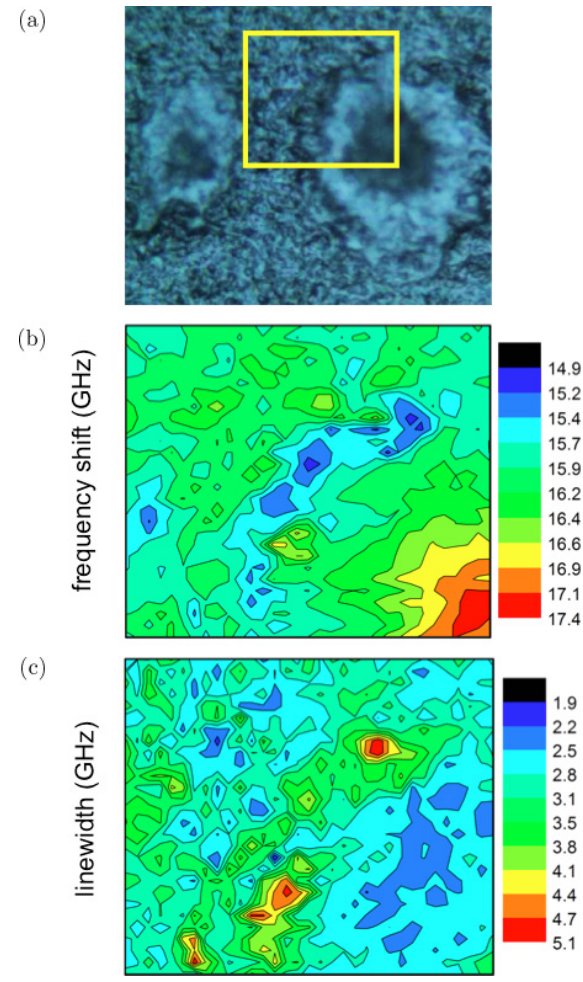
Fig. 5. (a) Photomicrograph of a TASTPM mouse brain hippocampal section containing two plaques. (Yellow box denotes a 50 (cid:1) 43 (cid:2) m 2 area where a Brillouin map was acquired using a 1.5 (cid:2) m step-size.) Maps based on the (b) frequency shift and (c) linewidth of the Brillouin peak derived from ¯t analysis of the spectra in the map. Red color region in (b) denotes the plaque core, whilst in (c) it denotes the lipid-loaded ring sur- rounding the